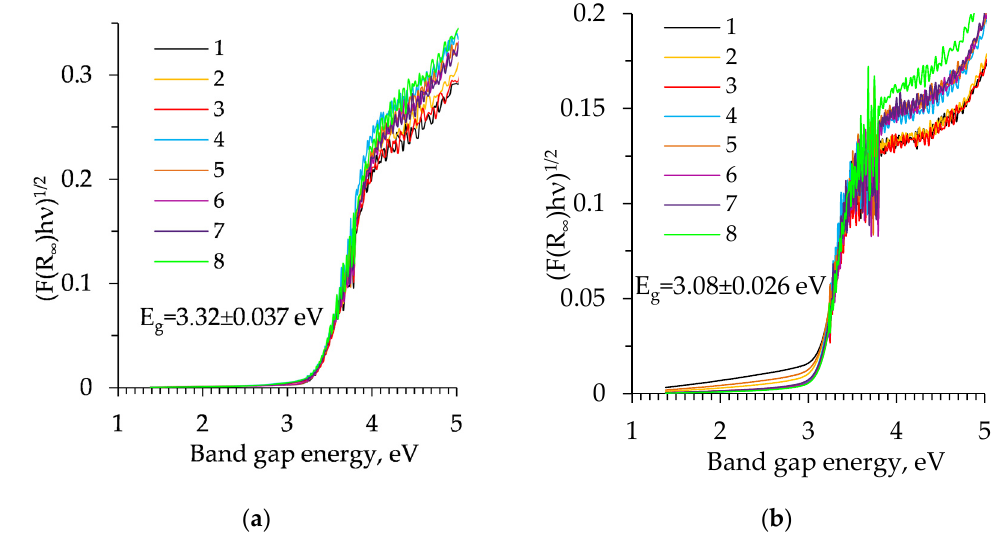
Figure 12. Tauc plot of TiO 2 aerogel powders: ( a ) before calcination; ( b ) after calcination ( 1 – 4 curves correspond to precursor TBOT and 5 – 6 to TIP; 1 , 3 —unaged and without solvent exchange; 2 , 4 —aged and without solvent exchange; 5 , 7 —unaged and nH exchanged; 6 , 8 —aged and nH exchanged).